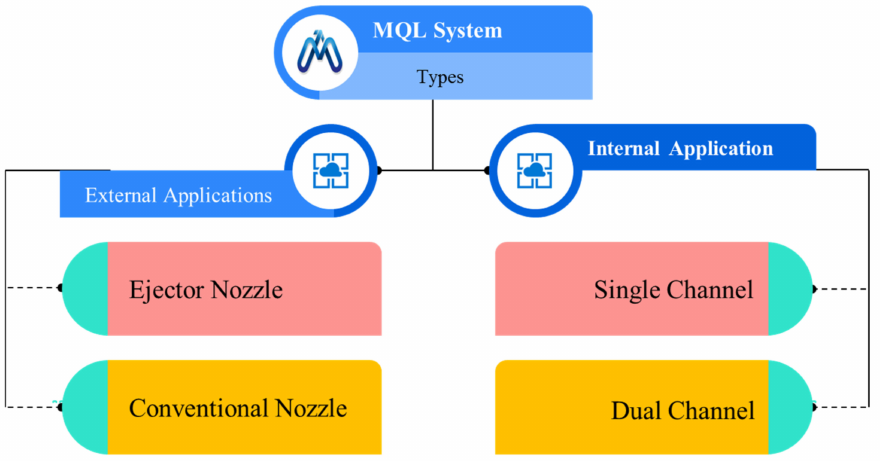
Figure 28. Different types of MQL systems, reprinted from ref. [108]. Copyright 2020 Elsevier